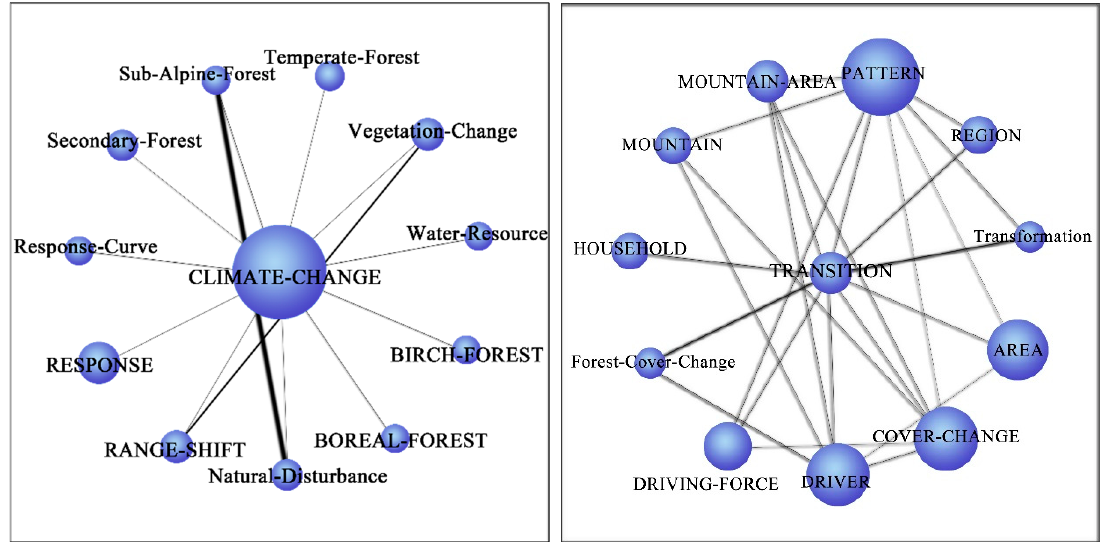
Figure 10. Climate-change and transition-cluster network map.